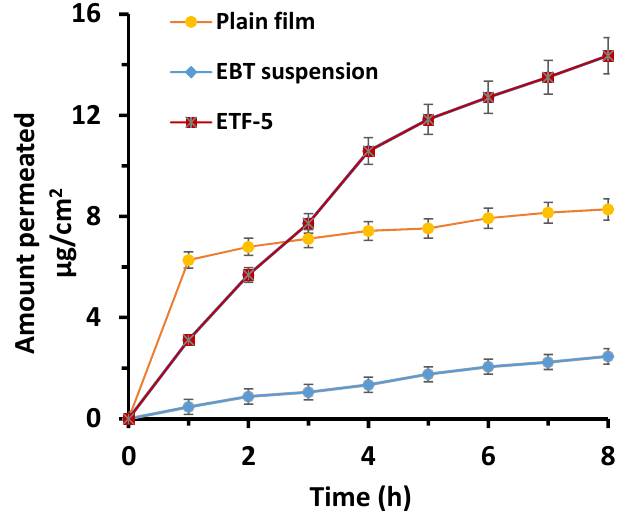
Figure 9. Ex vivo permeation studies of EBT suspension, EBT plain film and ETF-5 formulation.